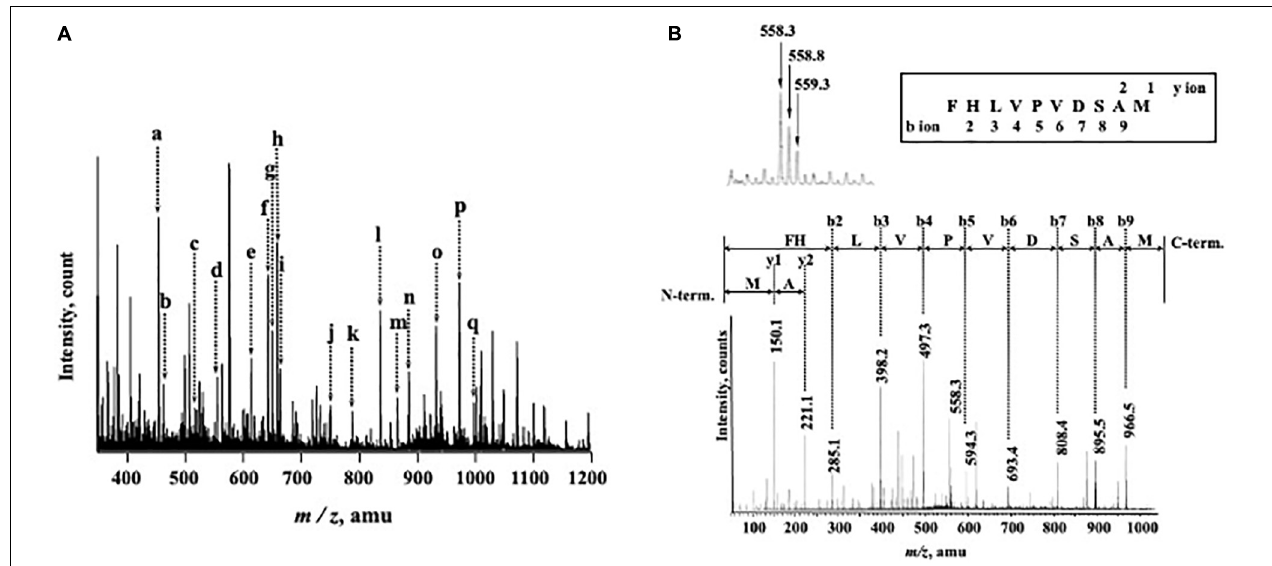
FIGURE 2 | ESI-TOF-MS analysis of tryptic peptides from purified Endo- β -GlcNAc-ase and MS/MS spectrum of peak-d ( m/z 558.3; C-terminal Peptide). (A) Doubly and triply charged tryptic peptides were obtained and further analyzed using MS/MS spectrometry. a, m/z 457.5 [(M + 2H) 2 + ]; b, m/z 466.2 [(M + 2H) 2 + ]; c, m/z 519.8 [(M + 2H) 2 + ]; d, m/z 558.3 [(M + 2H) 2 + ]; e, m/z 617.0 [(M + 3H) 3 + ]; f, m/z 645.8 [(M + 2H) 2 + ]; g, m/z 653.3 [(M + 2H) 2 + ]; h, m/z 661.8 [(M + 2H) 2 + ]; i, m/z 666.3 [(M + 3H) 3 + ]; j, m/z 752.9 [(M + 2H) 2 + ]; k, m/z 789.9 [(M + 2H) 2 + ]; l, m/z 838.7 [(M + 3H) 3 + ]; m, m/z 868.4 [(M + 2H) 2 + ]; n, m/z 887.4 [(M + 3H) 3 + ]; o, m/z 934.9 [(M + 2H) 2 + ]; p, m/z 974.5 [(M + 2H) 2 + ]; and q, m/z 999.0 [(M + 2H) 2 + ]. (B) MS/MS Spectrum of Peak-c ( m/z 558.3; C-terminal Peptide).